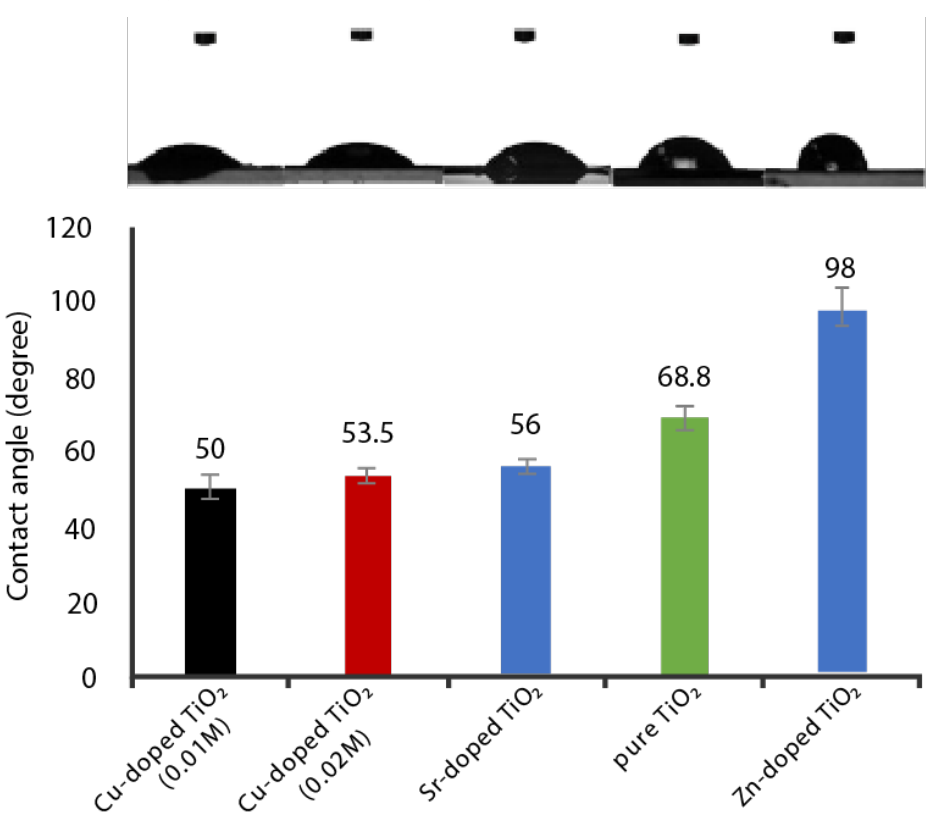
Figure 5. Contact angle measurements showing the degree of hydrophilicity of fabricated nanotube arrays (error bars show a standard deviation for n = 5 samples). The images of the water droplets on the fabricated nanotube arrays are shown above the chart.